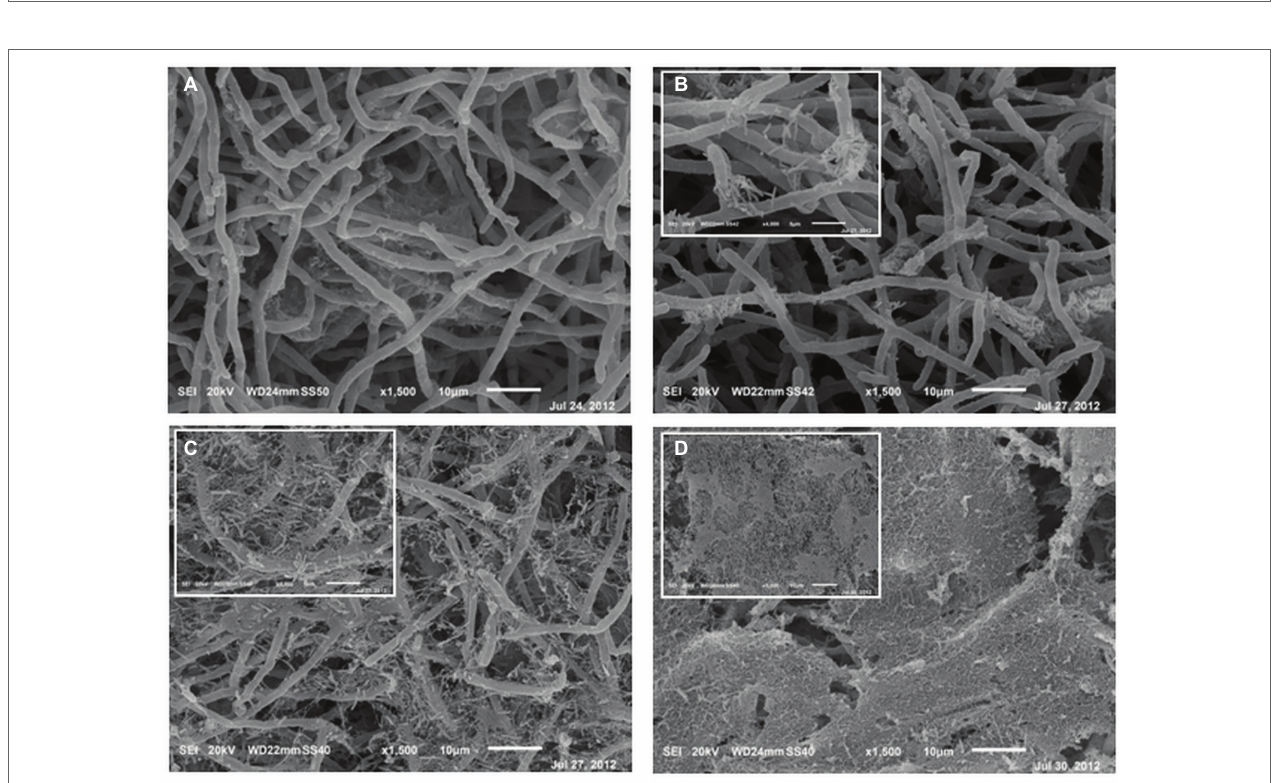
FIGURE 3 | Scanning electron micrographs of 4-day-old mono-specific P. ostreatus biofilm (A) and its mixed biofilms with P. alcaliphila obtained after 24 (B) , 48 (C) , and 72 (D) h of incubation at 30 ° C under orbital shaking (150 rpm) on MBEC™ HA-P&G system. All micrographs are at a 1,500× magnification while insets in (B) and (C) at higher magnification (4,000×). Inset in (D) shows the bacterial biofilm grown in the proximity of the air-liquid interface